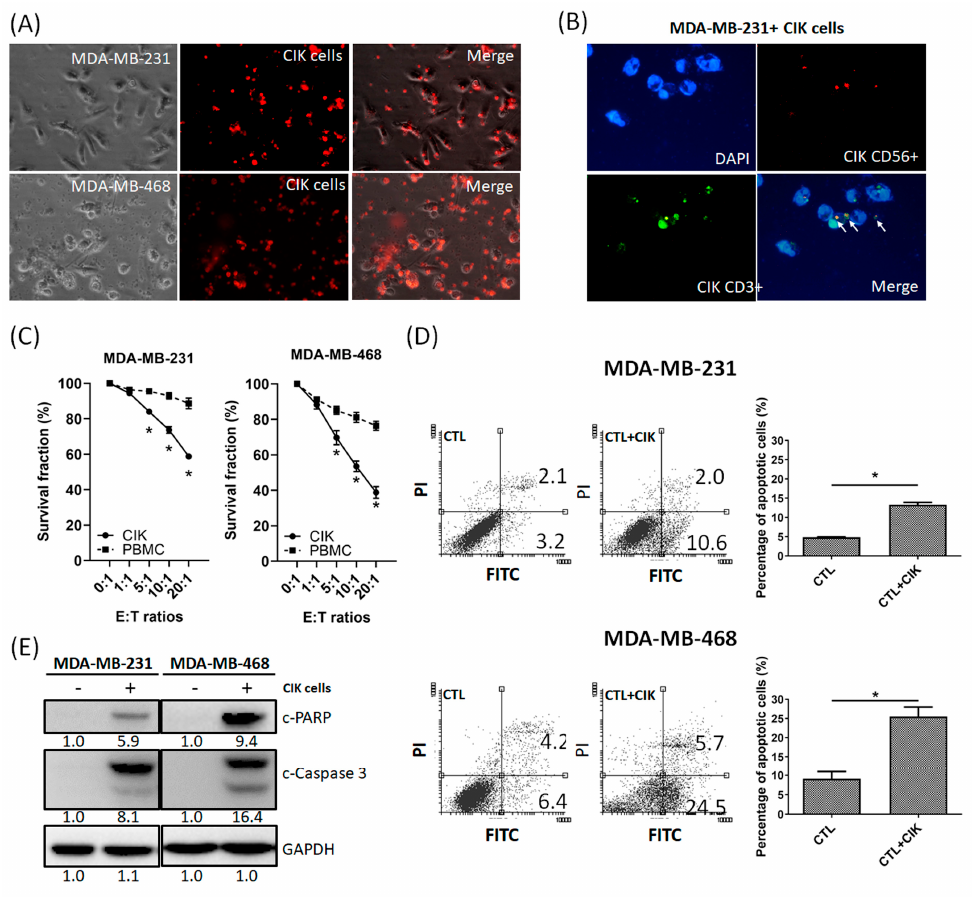
Figure 2. Cytotoxicity of CIK cells towards tumor cells. ( A ) Observation of the coculture of MDA-MB-231 with CIK cells (red) and MDA-MB-468 with CIK cells (red) (magnification, ×200). CIK cells adsorbed to and aggregated around the tumor cells. ( B ) Immunofluorescent (IFC) staining revealed CD3+ (green), CD56+ (red), and double-positive (CD3+CD56+) CIK cells around MDA-MB-231 cells. ( C ) Cytotoxicity of PBMCs and CIK cells against MDA-MB-231and MDA-MB-468 cells. PBMCs and CIK cells were cocultured with MDA-MB-231 and MDA-MB-468 cells at different tumor cell: CIK cell (T/C) ratios, ranging from 1:1 to 1:20 for 30 h, and were then subjected to the MTT assay. ( D ) Coculture of CIK cells with MDA-MB-231/MDA-MB-468 cells induced more cell death through apoptosis, as determined by AnV-PI double staining. ( E ) Western blot analysis showed higher PARP cleavage and Caspase-3 expression when MDA-MB-231/ MDA-MB-468 cells were cocultured with CIK cells. Data from three independent experiments were used for statistical analysis and * p < 0.05.